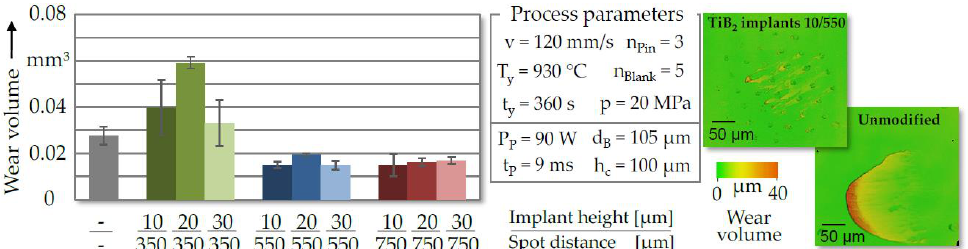
Figure 15. Quantified surface wear by using unmodified and laser-implanted tooling systems.